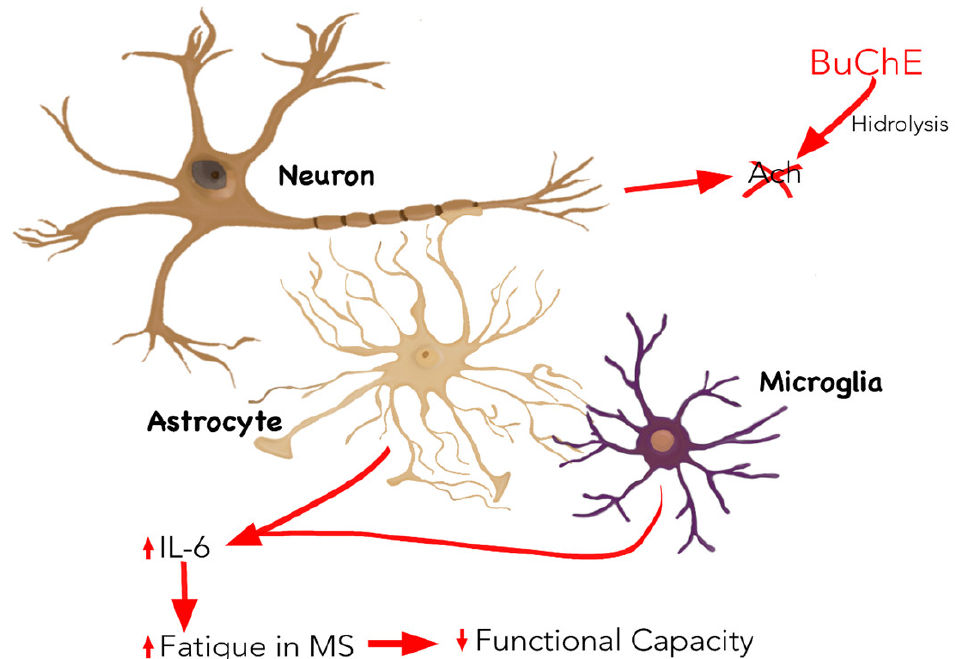
Figure 1. Inflammatory mechanism linked to MS in which BuChE is involved. BuChE is mainly expressed by neurons and hydrolysed ACh. An increase in BuChE activity, in particular, increases IL-6 production by decreasing ACh levels, which is associated with the appearance of fatigue, characteristic of MS, and an increase in functional disability. Abbreviations: Ach: acetylcholine ester; BuChE: butyrylcholinesterase; IL-6: interleukin 6; MS: multiple sclerosis.